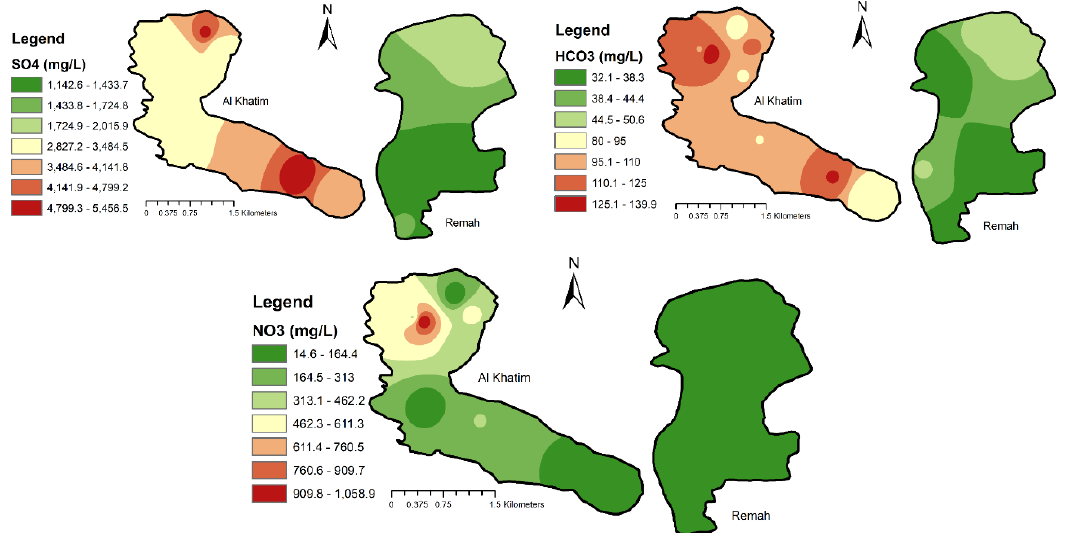
Figure 9. Spatial distribution of bicarbonate (HCO 3 ), sulfate (SO 4 ), and nitrate (NO 3 ) ions.